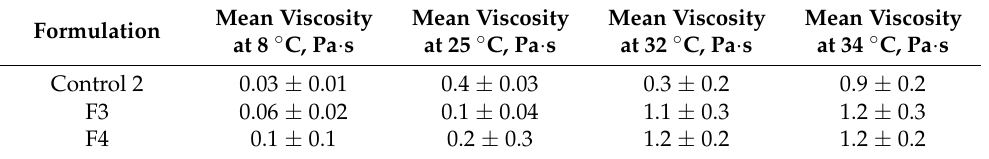
Table 5. Mean viscosities of Control 2, F3 and F4 at different temperatures.